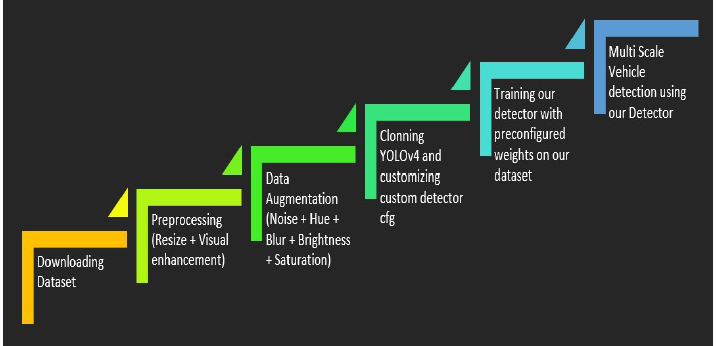
Figure 4. Flowchart of our proposed methodology.